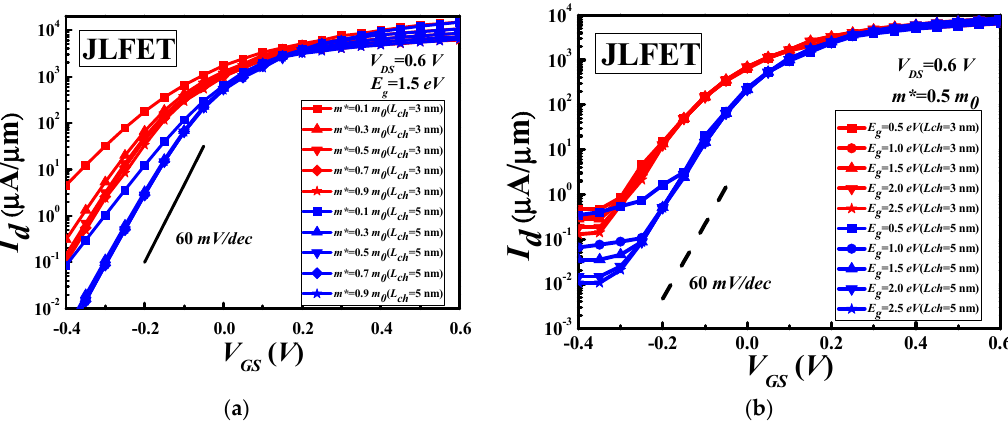
Figure 2. The transfer characteristics of JLFET with different lengths of channel and different bandgap for fixed E g ( a ) and m ∗ ( b ),